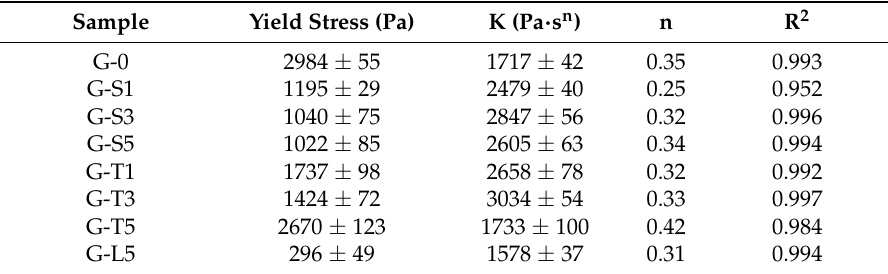
Figure 2. Results of the rheology tests performed on geopolymer pastes. ( a ) Flow curves of samples containing different amounts of Spirulina platensis ; ( b ) flow curves of samples containing different amounts of Tetraselmis suecica ; ( c ) comparison between flow curves of samples with different biomasses ( Spirulina , Tetraselmis and lignin) at 5 php addition; ( d ) values of yield stress obtained by fitting the flow curves with Hershel–Bulkley’s model. Table 4. Herschel–Bulkley’s parameters obtained from the fitting of flow curves.